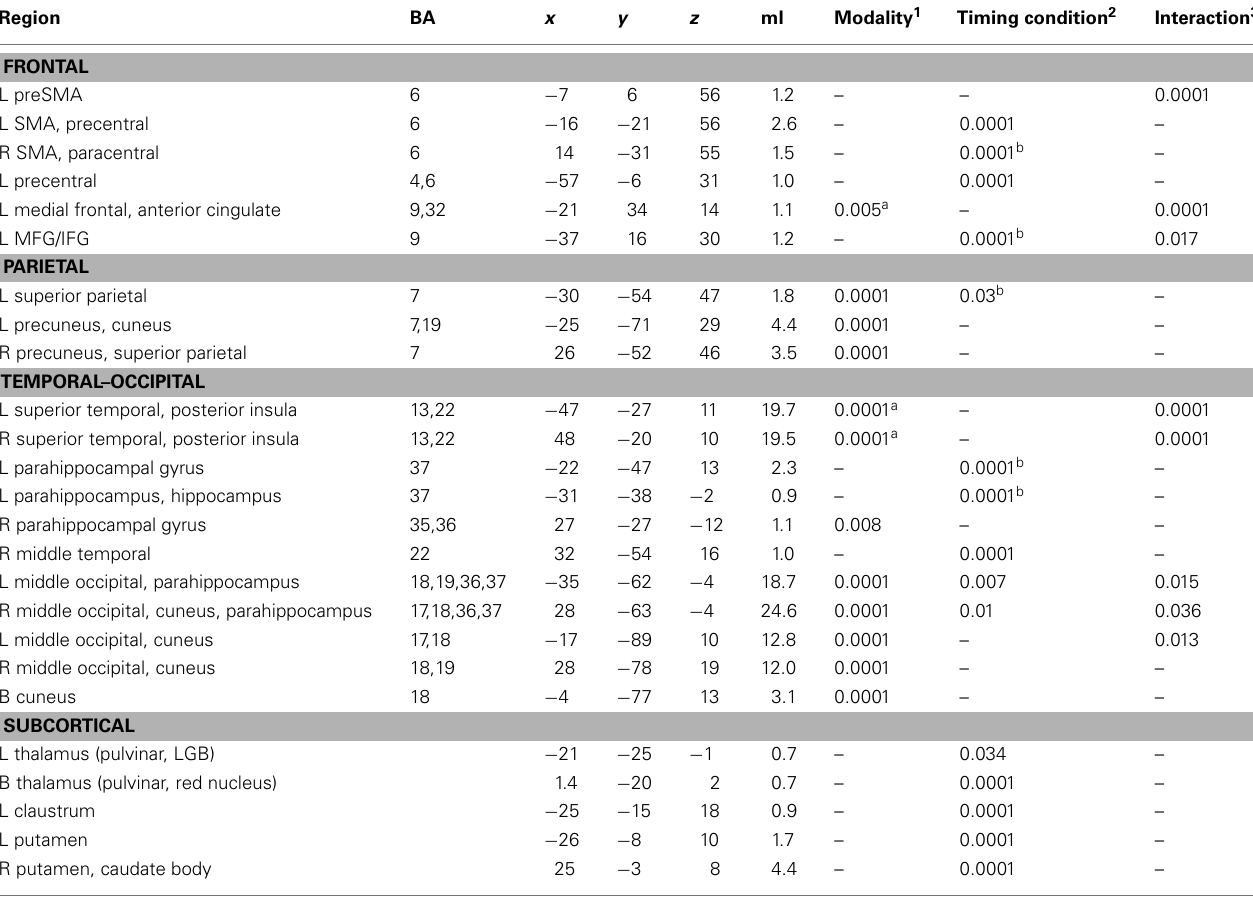
Table 1 | Regions showing significant effects of modality, timing condition, and the interaction.